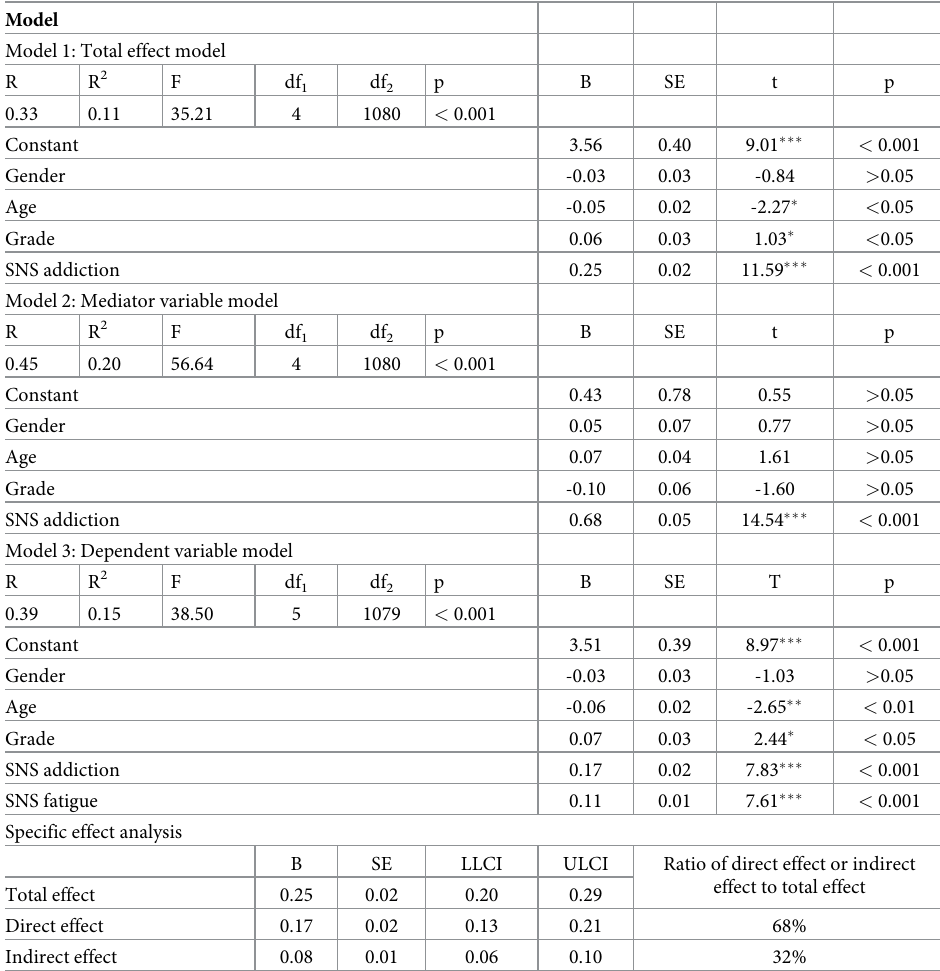
Table 2. Regression results for the mediation model.